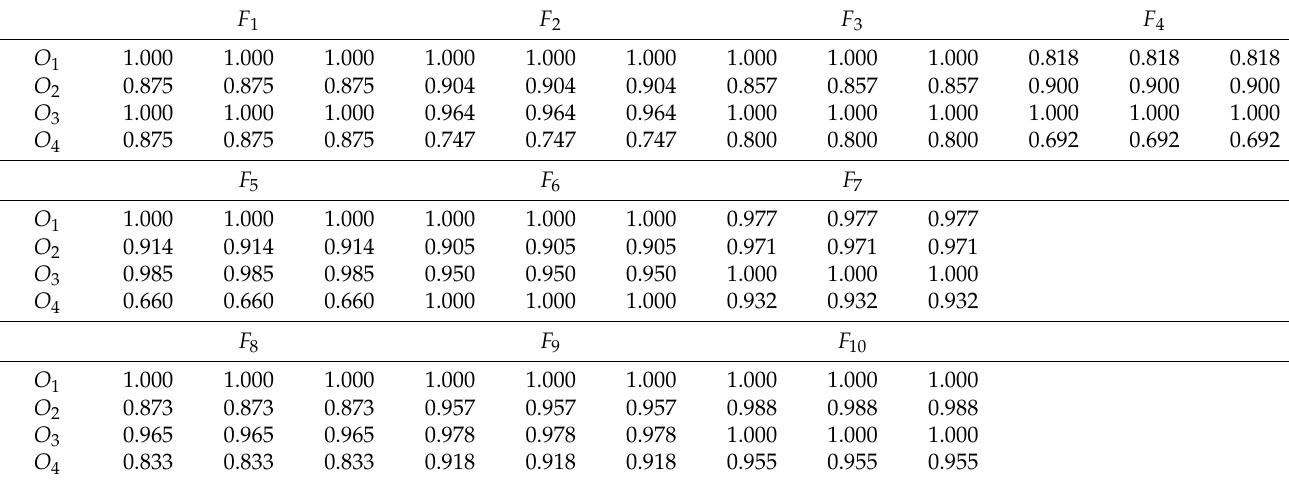
Table 15. Normalization of values under quantitative criteria.